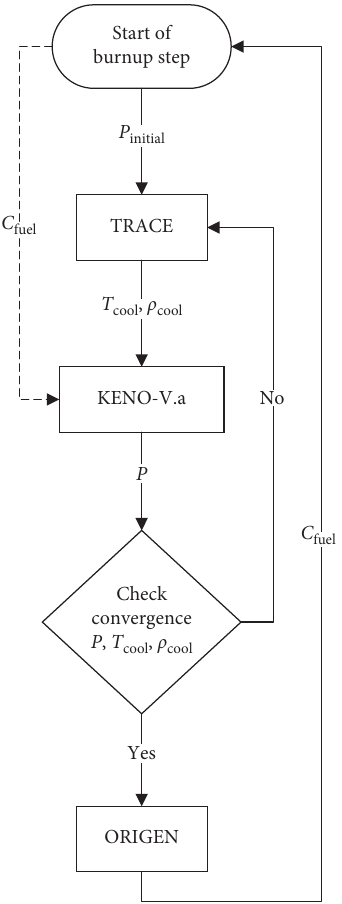
Figure 3: Process flow diagram for T5-DEPL, TRACE coupling. gives the nodal fuel composition, The notations are as follows: C fuel P is the nodal power distribution, and T and ρ are tem- cool cool is the perature and density of the coolant, respectively. P initial converged power profile of the previous burnup step. For the first burnup step, P is a uniform power density to begin the iterative initial